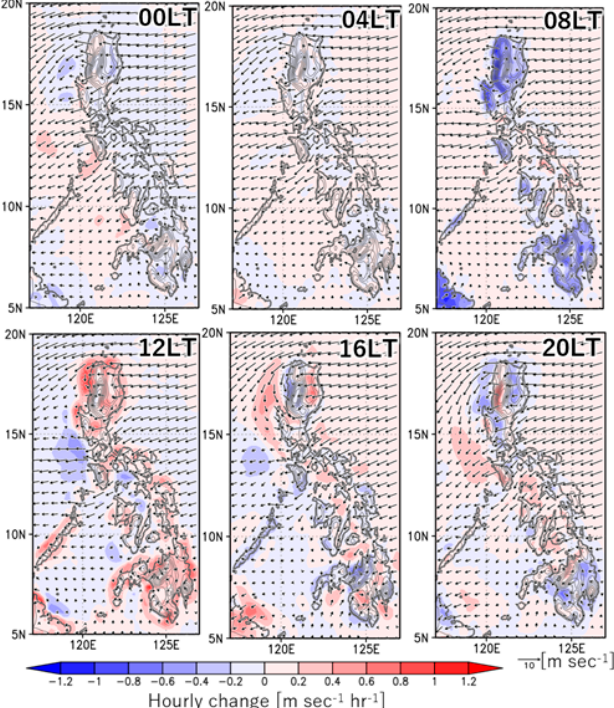
Figure 6. Spatial distribution of mean hourly change of wind speeds (shaded; m/s/h) and the direction of the hourly mean winds (vectors) at every four-hour interval. The hourly changes are computed by the previous hour subtracted from the current hour.